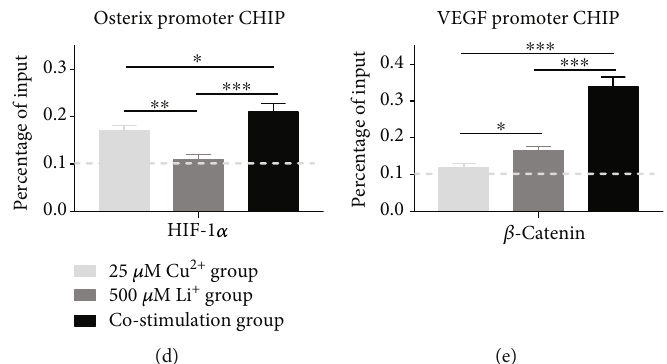
Figure 6: Lithium and copper costimulation can promote osteogenesis and angiogenesis via crosstalking between the canonical Wnt and HIF-1 α signaling pathways. (a) The BMSCs were exposed to 25 μ M copper, 500 μ M lithium, and costimulation. The Alizarin Red staining was performed to investigate the calcium nodules after four weeks of stimulation. The immuno fl uorescence (IF) staining was used to detect the VEGF expression in the BMSCs after 7 days of coculture. (b, c) The osteogenesis (ALP, osterix) and angiogenesis (VEGF) genes were detected by RT-qPCR and western blot in the BMSCs under 25 μ M Cu 2+ , 500 μ M Li + , and costimulation intervention for 7 days. (d, e) ChIP analysis for HIF-1 α , β -catenin, osterix, and VEGF promoter binding site following stimulation with 25 μ M copper and 500 μ M lithium or costimulation for 7 days. n = 5 holes per group. Data shown are of a single representative experiment with an experiment repeated two times with three technical replicates in each experiment. The results are depicted as the mean ± SEM . ∗ P < 0 : 05 , ∗∗ P < 0 : 01 , and ∗∗∗ P < 0 : 001